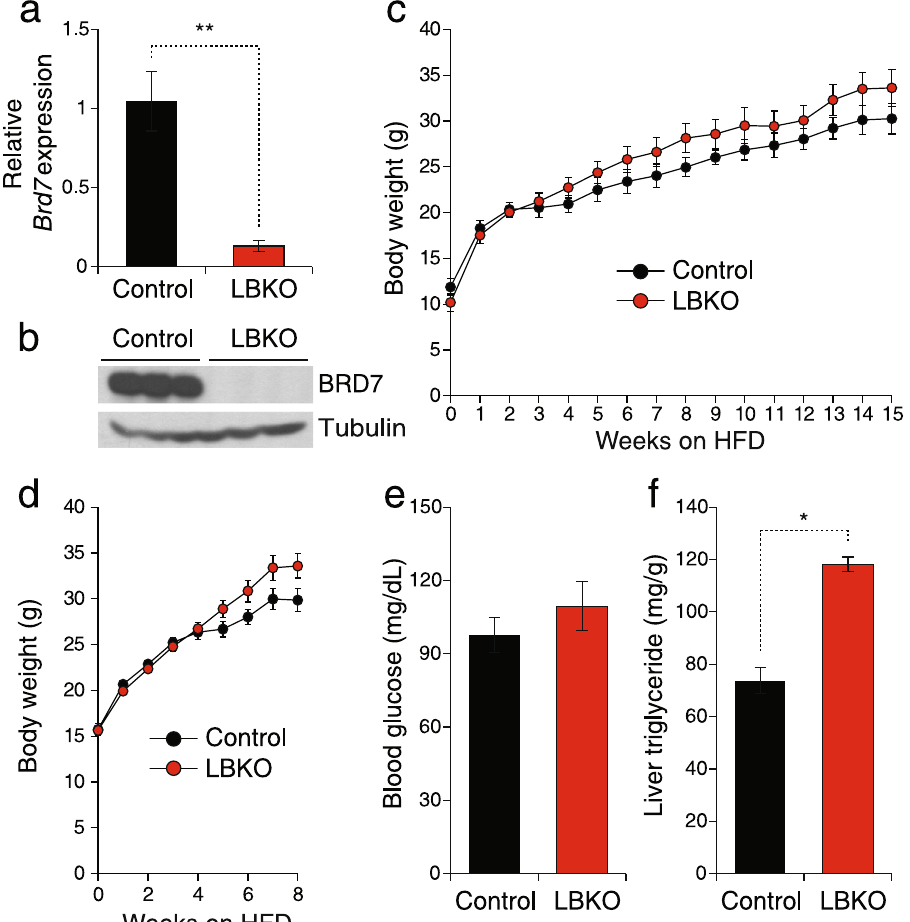
Figure 4. Liver-specific BRD7 knockout mice fed on a HFD display increased body weights. ( a ) Relative mRNA levels of Brd7 normalized to 18 s in the liver of LBKO and control mice at the 6-hour fasted state. ( b ) Immunoblot of BRD7 in the liver of LBKO and control mice. ( c ) Body weights of male control and LBKO mice over 15 weeks on a HFD (n = 7/group). ( d ) Body weights of control and LBKO mice over 8 weeks on a HFD (n = 7/group). ( e ) Blood glucose levels after 6 hours of fasting on week 8 of HFD feeding. ( f ) Liver triglyceride contents. Mice were fasted for 6 hours. Error bars are represented as mean ± SEM., P values were determined by Student’s t -test. ( * p < 0.05, ** p < 0.01, *** p < 0.001). Significance was determined by two-way analysis of variance (ANOVA) with Bonferroni multiple-comparison